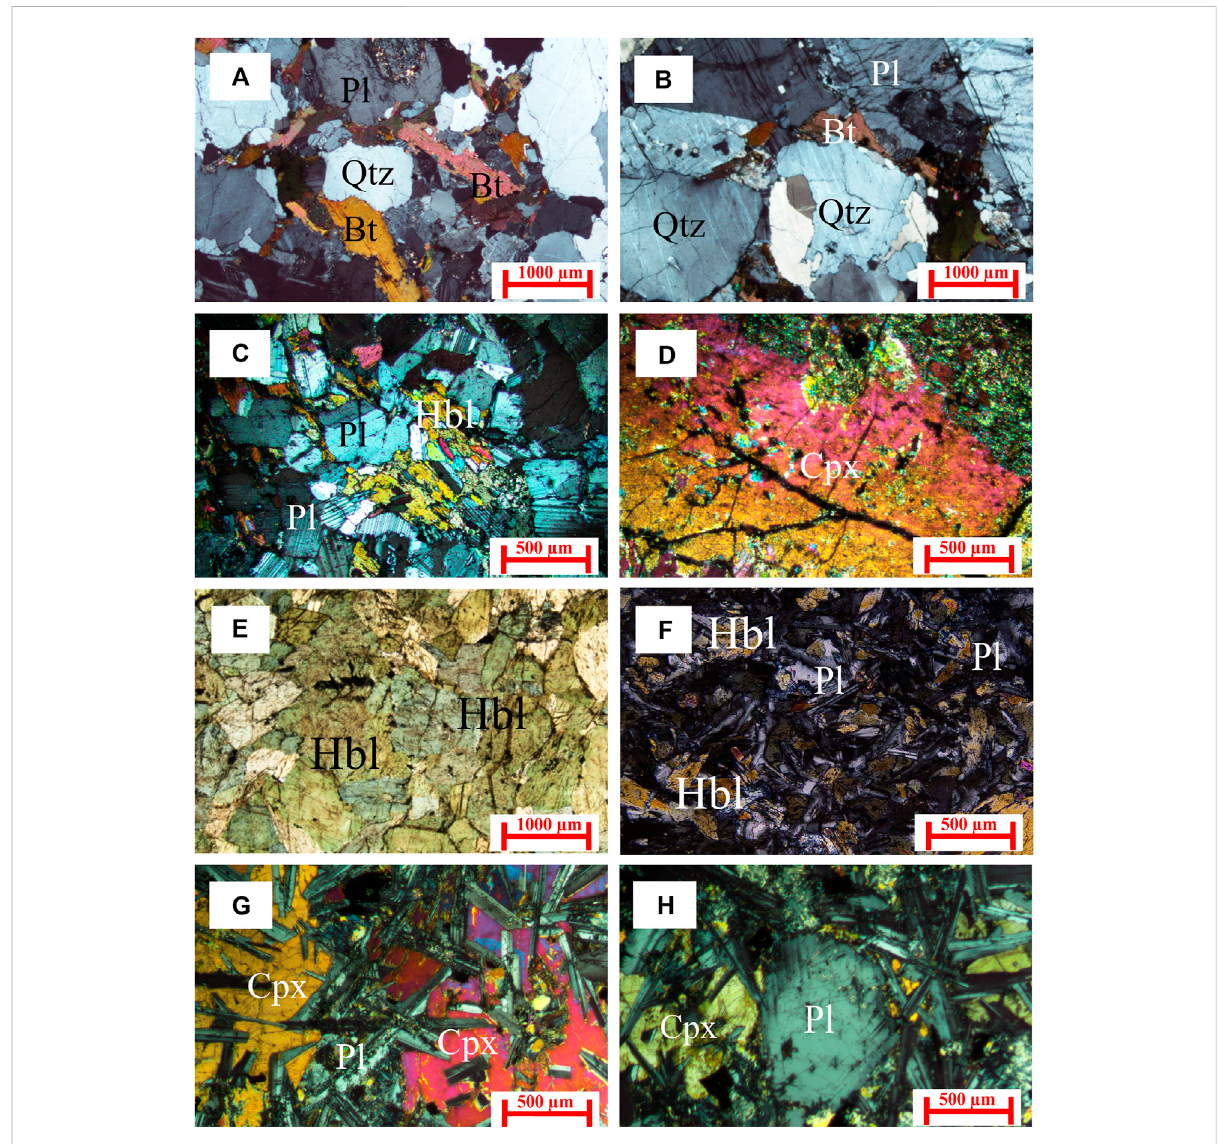
FIGURE 5 Photomicrograph of (A,B) granite host rock showing association of quartz, biotite, and feldspars. (C) anorthosite showing cumulate grains of anorthite with intercumulus hornblende, (D) pyroxenite with phenocryst of clinopyroxene, (E) hornblendite showing cumulate texture with a hornblende volume percentage of ~80 – 90%, (F) typical assemblage of plagioclase and hornblende and biotite in diorite. (G,H) dolerite with the typical assemblage of pyroxene and plagiocalse showing ophitic to subophitic